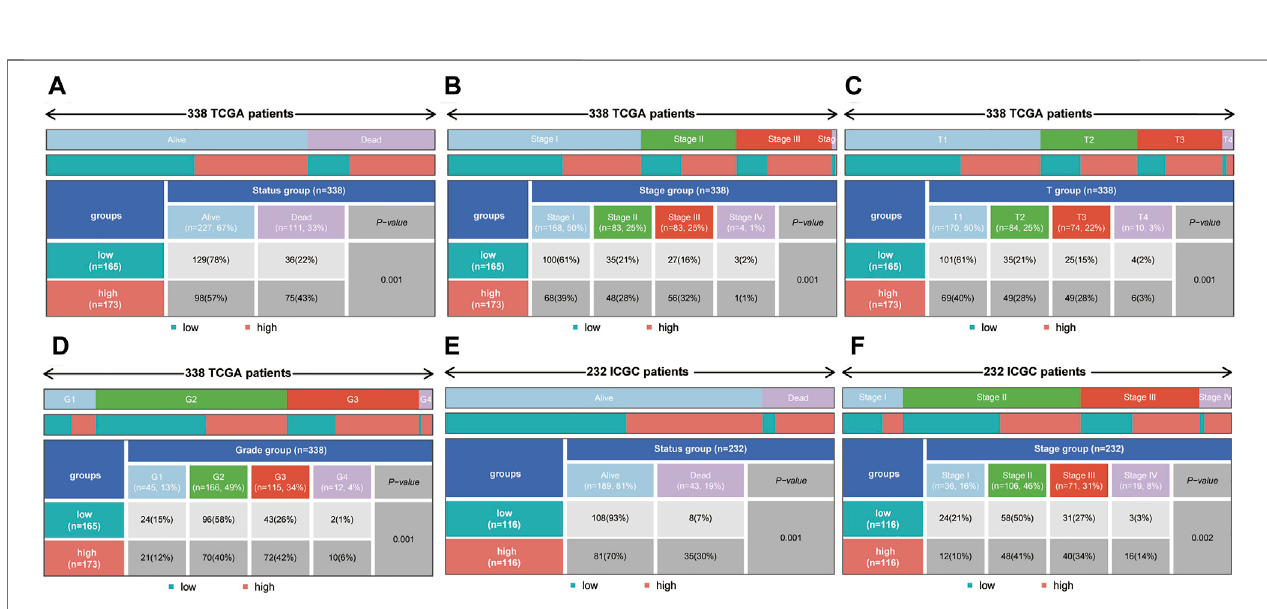
FIGURE6| Comparisonofgenemutationsbetweenthehigh-andlow-riskgroups. (A,B) Comparisonofgenemutationratebetweenhigh-andlow-riskgroup. (C) Comparison of risk score between TP53 mutation group and TP53 wild group. (D) Comparison of TP53 mutation ratio between high- and low-risk group. (E) Comparison of mRNAsi between high- and low-risk group. (F) Heat map showed the difference in immune function between the high- and low-risk group. Asterisks indicate statistical signi fi cance at: *: p < 0.05; **: p < 0.01, and ***: p < 0.001.